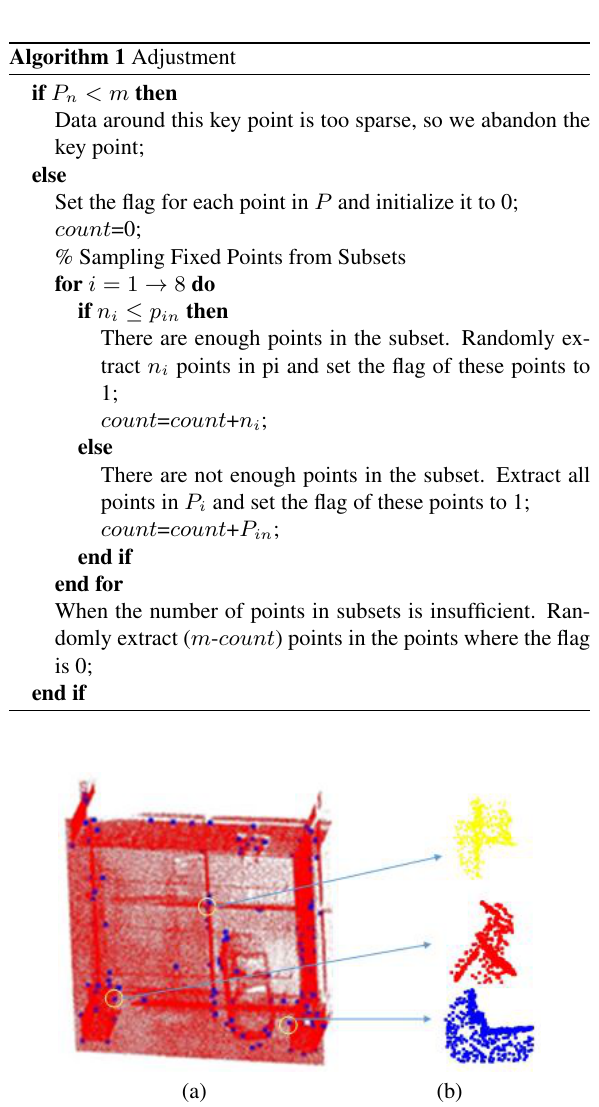
Figure 1. The Siamese network architecture